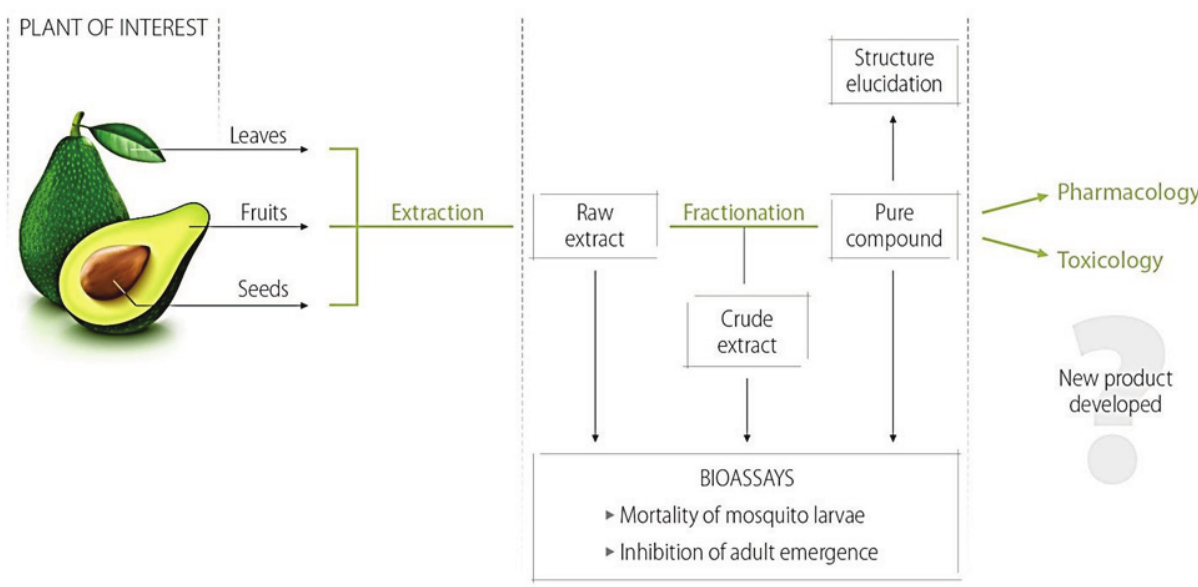
Figure 3. Strategies for obtaining active compounds from plants with larvicidal activity against